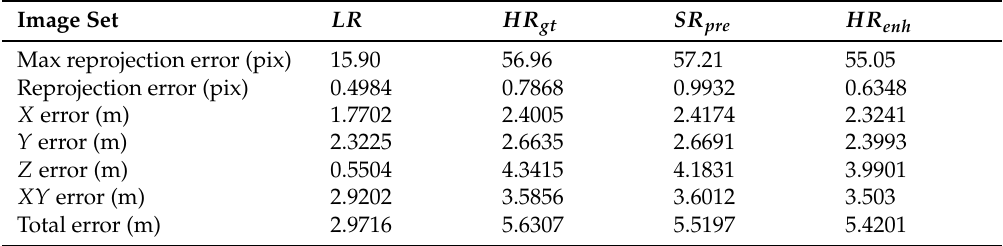
Figure 10. Average reprojection error vectors plotted on image space. Colors of the error vectors represent increasing magnitudes of the reprojection error progressing from blue to red respectively. The scale bar at bottom shows the magnitude of the error vector in pixel units. Table 4. Bundle adjustment results for reprojection and camera location